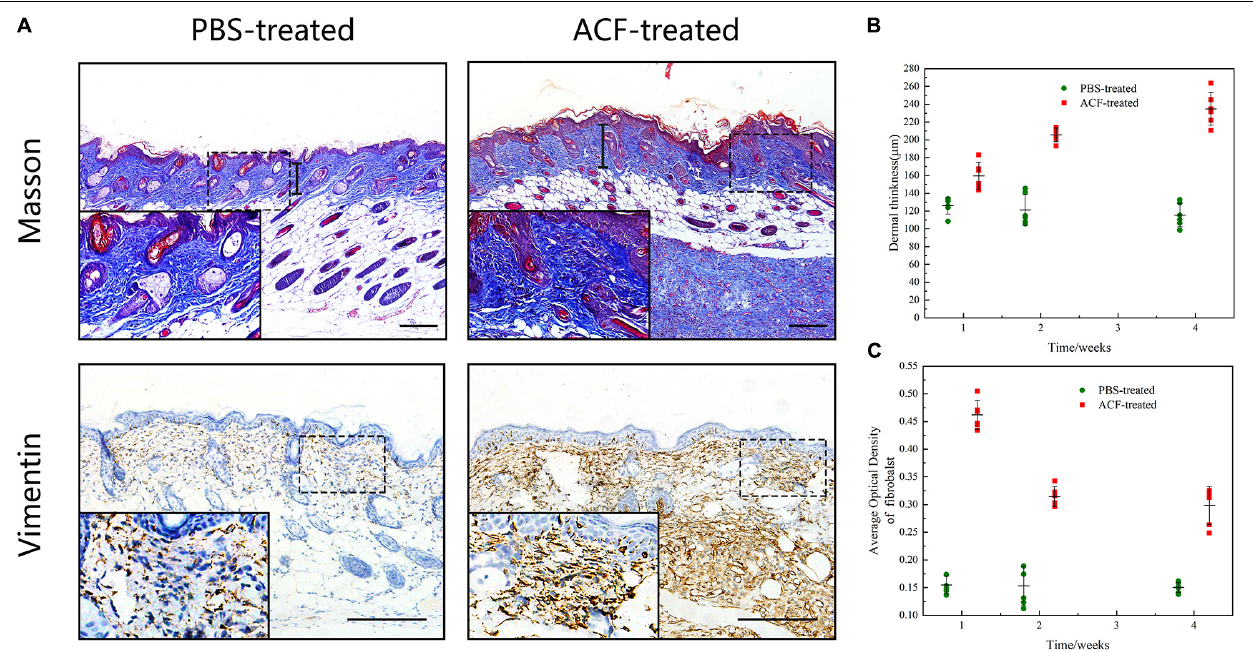
FIGURE 10 | Masson staining and the fibroblast expression of mouse skin samples. (A) Dermal thickness and the fibroblast expression of both groups at week 1. The arrows indicate the dermal portion of the skin. The significantly higher level of dermal thickness and fibroblast expression was detected in the ACF-treated group. (B) Semi-quantitative analysis of the dermal thickness of both groups at all-time points. P (week 1) = 0.001, F (week 1) = 0.309; P (week 2) = 7.438E-07, F (week 2) = 0.098; P (week 4) = 1.50E-07, F (week 4) = 0.472. (C) Semi-quantitative analysis of the fibroblast expression in the dermis of both groups at all-time points. P (week 1) = 2.223E-10, F (week 1) = 0.300; P (week 2) = 1.400E-06, F (week 2) = 0.160; P (week 4) = 1.063E-06, F (week 4) = 0.297. Scale bar = 200 µ m.